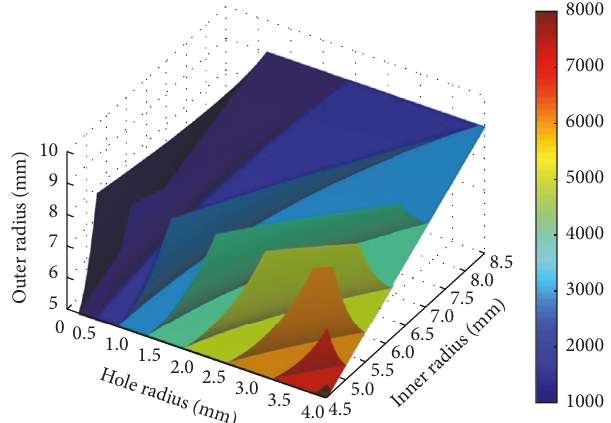
Figure 4: Relation between the parameters of SHS and the reso- nance